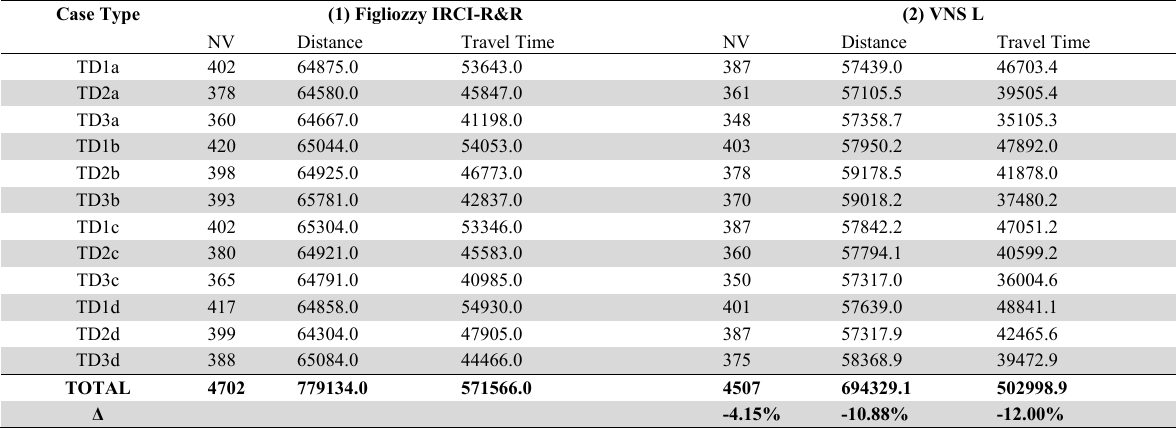
Total Number of vehicles, distance and travelled time in all 56 problems (100 customers) in each of